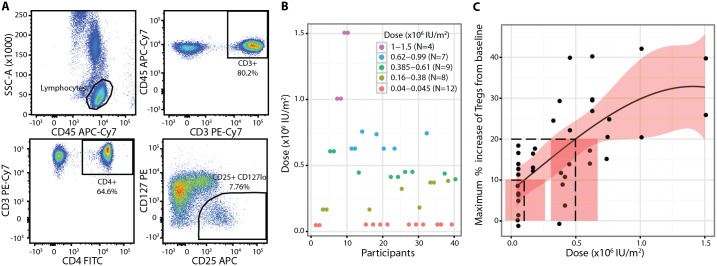
Regulatory T cell primary endpoint.(A) Percentage of Tregs was defined as the percentage of CD3+CD4+CD25highCD127low cells within the CD3+CD4+ gate measured. (B) Individual participant dose allocations and dose groups showing convergence of the study to doses that achieve the two defined Treg targets. (C) A cubic model described the Treg dose response to aldesleukin best, with dashed lines showing the 10% and 20% Treg targets and doses. The shaded areas represent 95% CIs. Baseline, or pretreatment, Treg (percent of CD4+ T cells): 6.60% (SE = 0.25%, range 3.50%–10.70%, n = 39). SSC-A, side-scattered light-A; Treg, regulatory T cell.